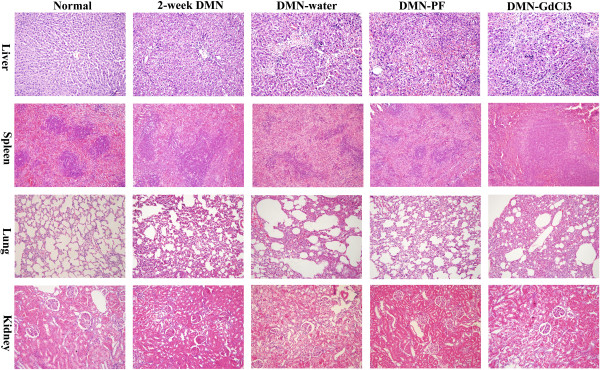
Effects of PF on H&E staining in different organs in DMN-induced rat liver fibrosis ×200 magnification.